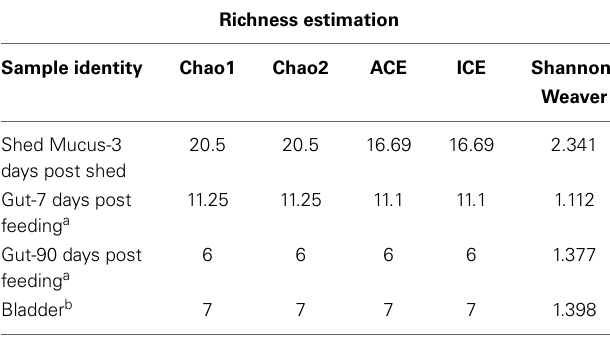
Table 2 | Species richness and coverage estimation of 16S rRNA clone libraries generated from H. verbana microbial niches.